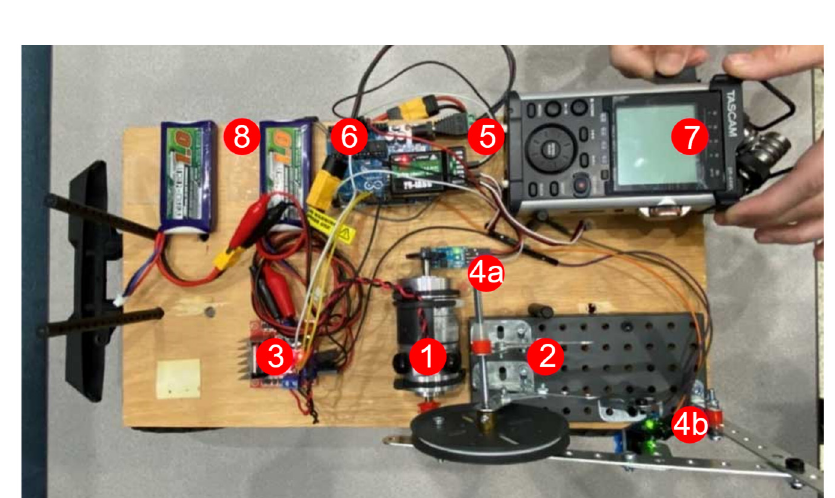
Figure 3. BRUTUS 1 component diagram, components labeled with numbers. Table 1. Major components of BRUTUS 1.